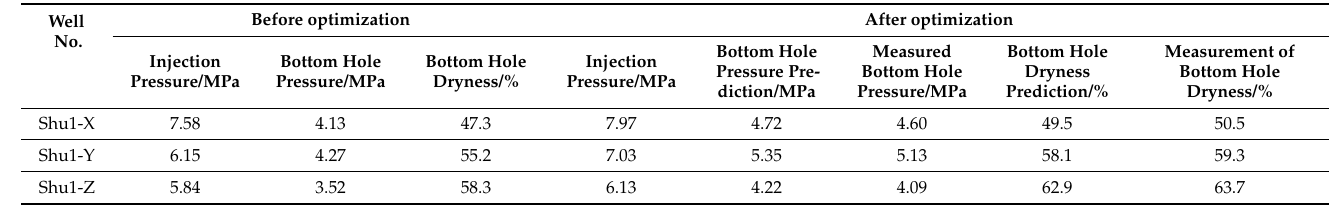
Table 4. Comparison of wellbore steam dryness before and after optimization of nitrogen insula- tion process